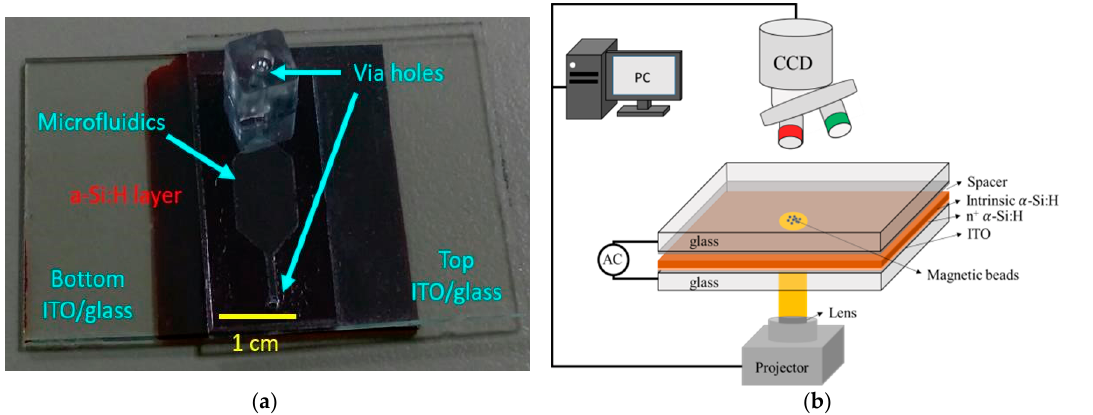
Figure 1. ( a ) Picture of real chip and ( b ) Schematic plot of operation setup.